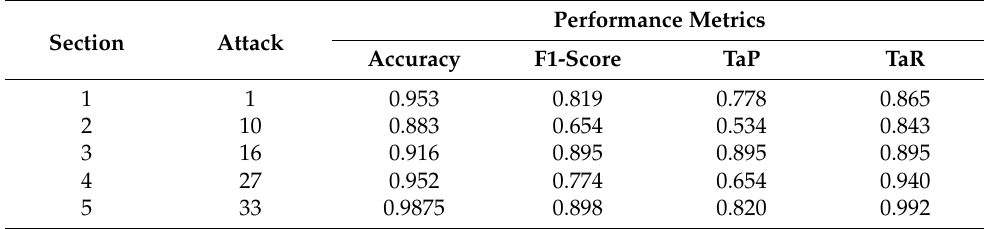
Table 10. Comparison of performance metrics by attack.